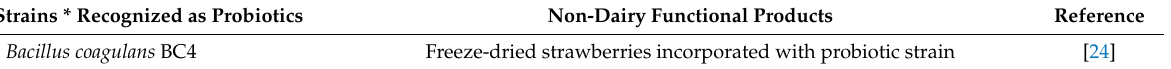
Table 2. Probiotic strains * used in non-dairy food for vegans and lactose-intolerant vegetarians. Microbial Strains * Recognized as